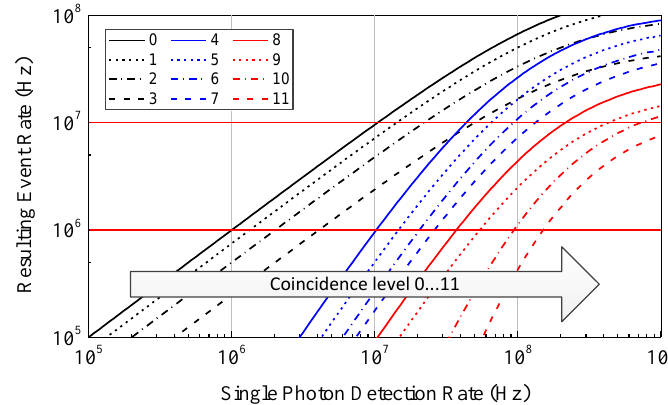
Figure 7. Resulting event rate versus the single photon detection rate according to our theoretical model for the coincidence levels in Table 1. The chosen parameters result in a decreasing event rate between 1 MHz and 10 MHz if passed through in ascending order.